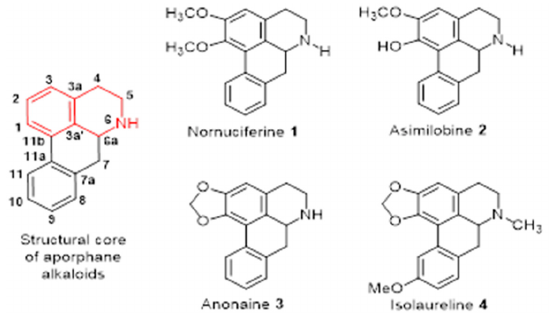
Figure 3. Basic structure of aporphine alkaloids with its systematic numbering ( left ), present in several species of genus Annona . The isoquinoline nucleus is shown in red. Structures of the major alkaloids ( right ) identified in alkaloid-enriched fractions F105-F150 obtained from the fruit of Annona muricata .